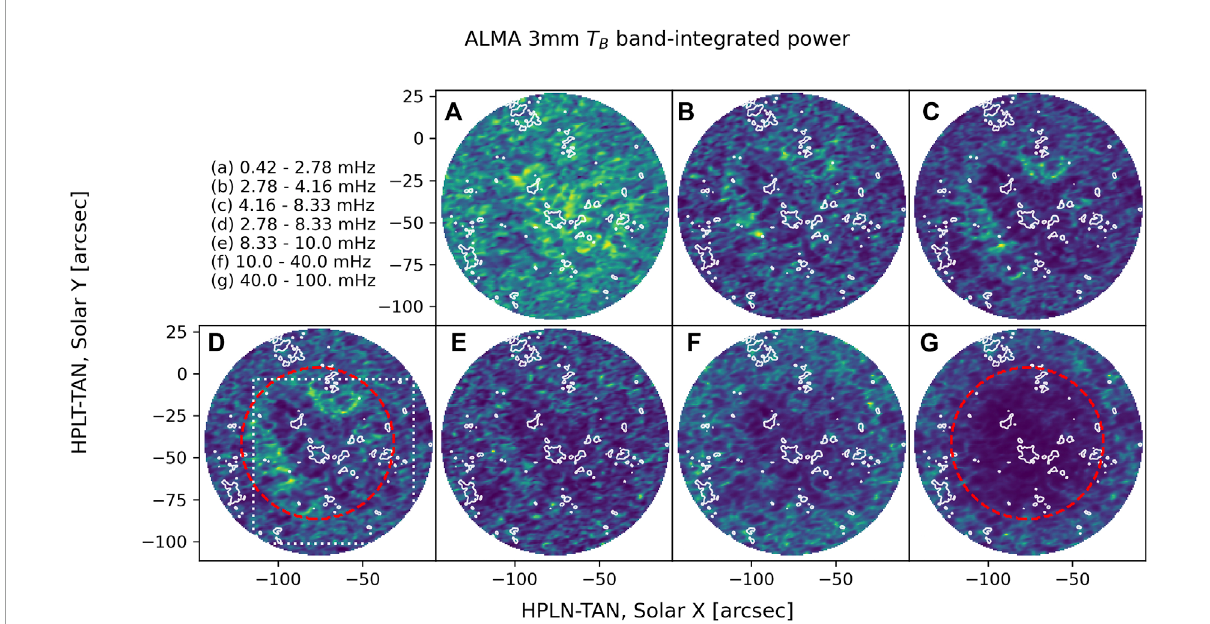
FIGURE 11 Same as Figure 9 but for the ALMA 3 mm brightness temperature and a slightly larger field of view. The outer boundary has a 67 ′′ radius while the red dashed circle shows a 45 ′′ diameter, both relative to the ALMA beam center. The white dotted rectangle in (D) indicates the IBIS FOV. The frequency bands correspond to: (A) low frequencies; (B) 5 min oscillations; (C) 3 minute oscillations; (D) combined p-modes; (E) near-cutoff; (F) mid frequencies; (G) high frequencies.